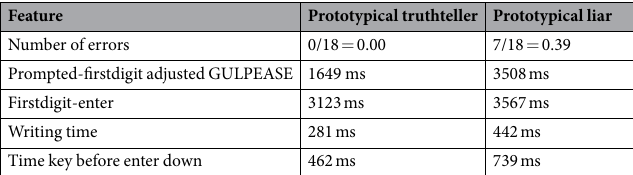
Table 8. Table reports the prototypical keystroke pattern of a liar and a truthteller for the 5 predictors used in the classification models. The number of errors is defined as the number of fields compiled by entering the wrong information. The prompted-firstdigit adjusted GULPEASE, is the interval between the onset of the sentence on the computer screen and the first key pressed. The firstdigit-enter is the time between the press of the first key and the press of ENTER. The writing time corresponds to the firstdigit-enter divided by the number of characters typed. The time key before enter down is the time between the press of the last key and the press of